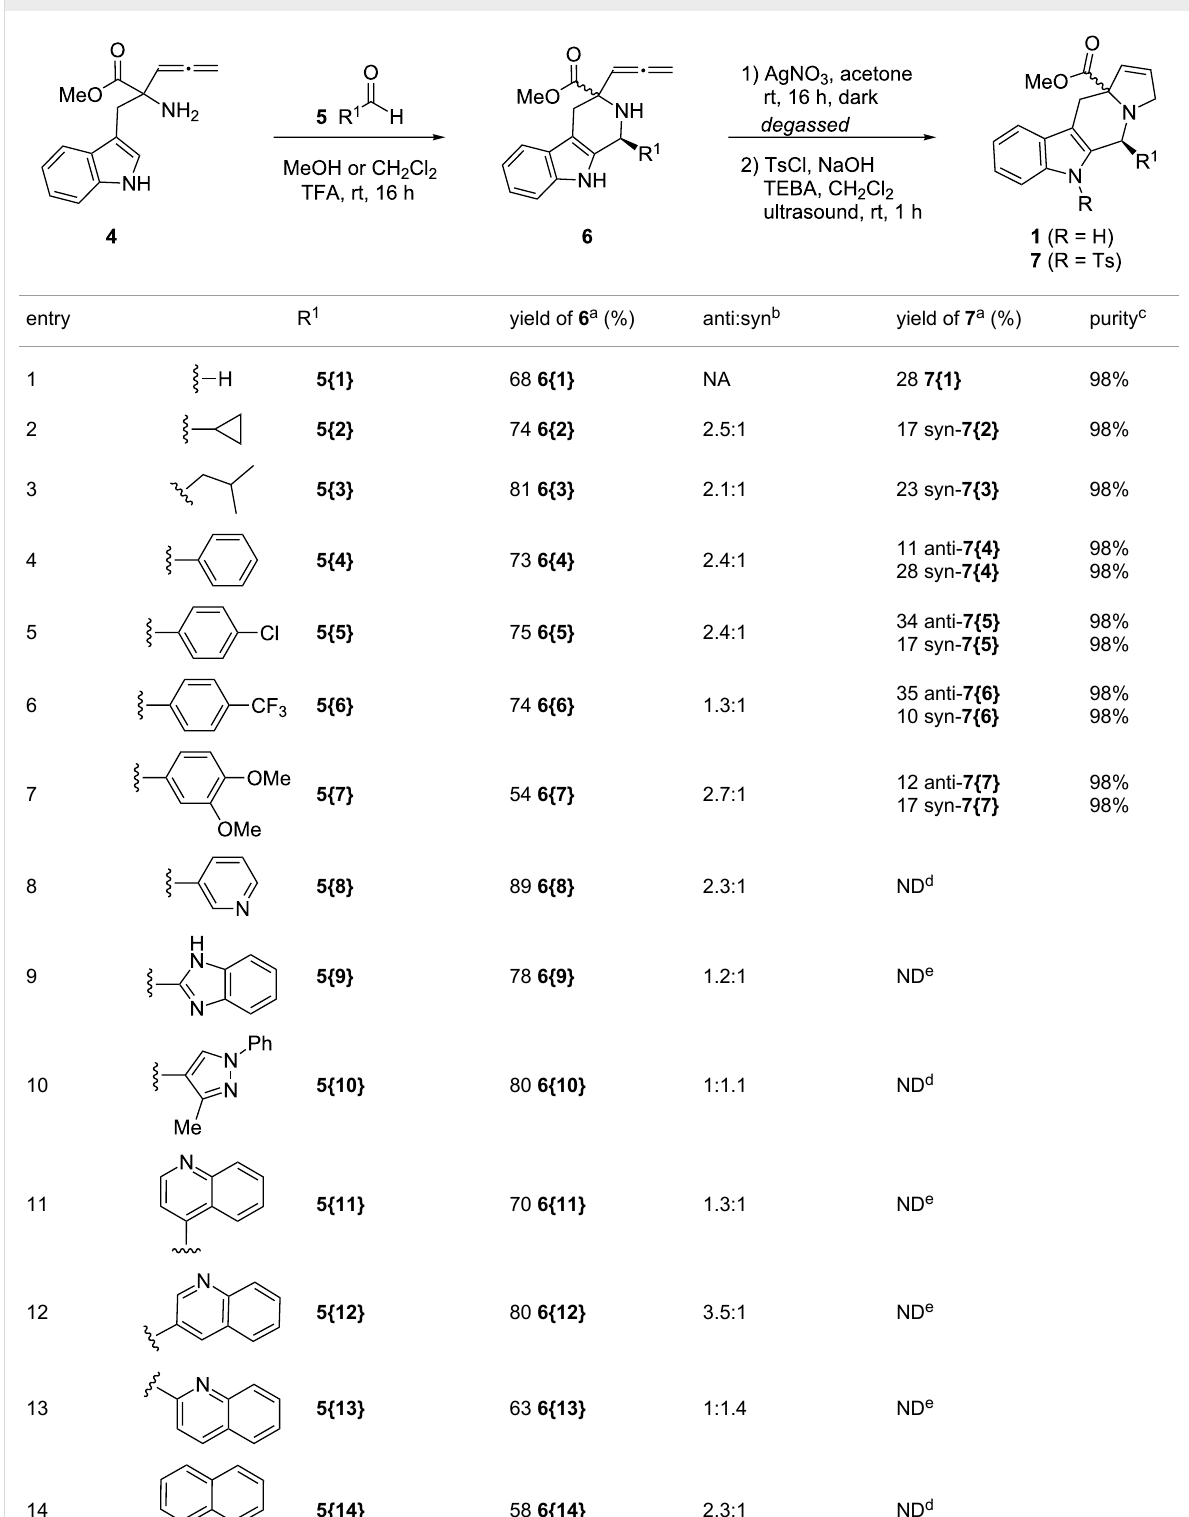
Table 1: Library of N -tosyltetrahydro- β -carbolinepyrrolines 7{1–7}